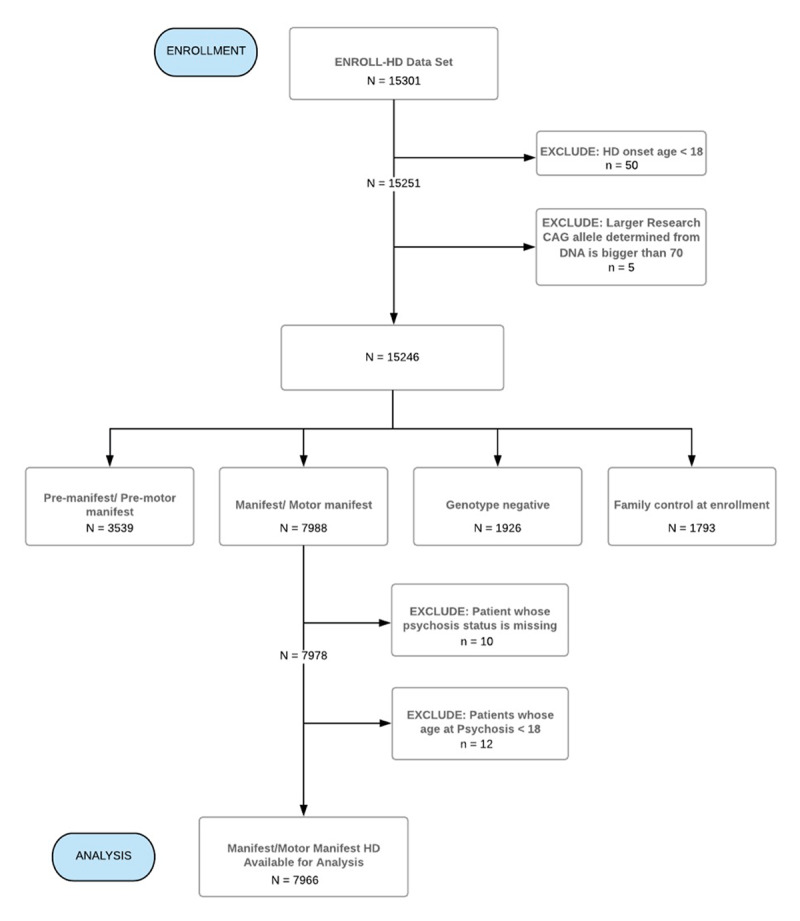
Consort Diagram for HD Psychosis Analysis Group Selection. Inclusion & exclusion criteria and breakdown of participant group included in analyses of psychosis in HD. In addition to non-manifest/motor-manifest HD participants being excluded, those with an HD onset age < 18 or a CAG repeat length > 70 were also omitted. Among the 7988 manifest/motor-manifest HD participants remaining, 10 participants were excluded due to missing data on psychosis status, and 12 participants were excluded due to childhood onset of psychosis. Our final analysis group included 7966 manifest/motor-manifest HD participants, of which 1021 had psychosis and 6945 did not.